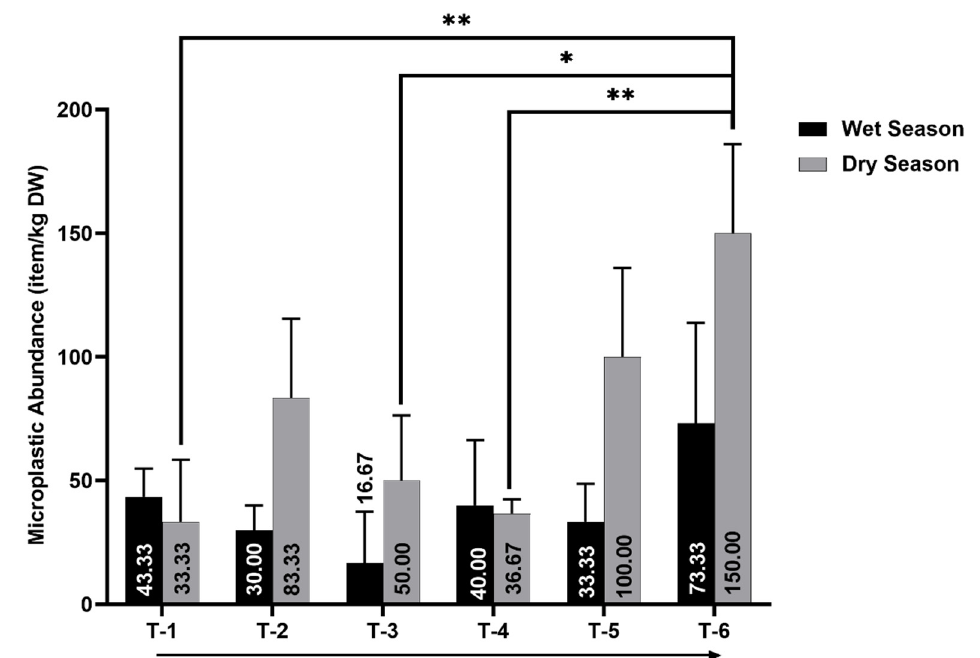
Figure 4. Microplastic abundance in sediment from Tallo River. The arrows below the graph indicate the position of every site from the upstream to the downstream part of the river. The error bar indicates standard deviation ( n = 3). The asterisk (*) indicates the significant difference between the sites based on a one-way ANOVA ( p < 0.05). The double asterisks (**) indicate the higher significant difference between the sites ( p < 0.01)